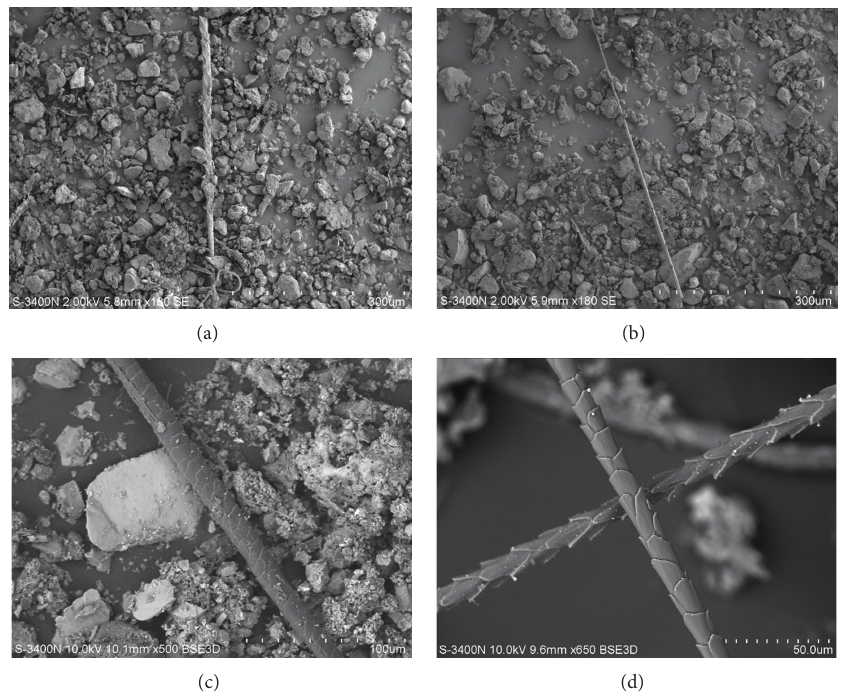
Figure 2: Scanning electron microscopy in secondary electrons: (a) and (b)—hair of unknown animal (sheep Ovis aries ?) from a snow sample collected in Zmeinka District, Vladivostok—; the sample was taken during a dust storm in Mongolia 04.09.2012. Magnification × 180. (c) Hair of a dog ( Canis familiaris ) from a snow sample taken in a one district of Blagoveshchensk. Magnification × 500. (d) Hair of a cat ( Felis domesticus ) from a snow sample taken around the Main Railway Station, Blagoveshchensk. Magnification × 650.